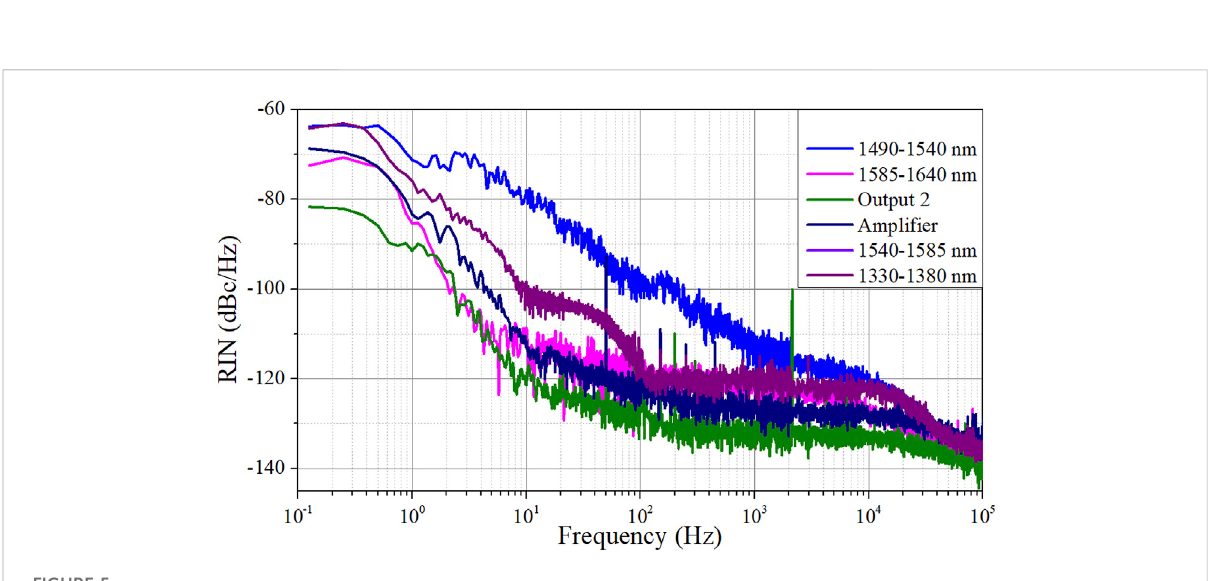
FIGURE 5 Relative intensity noises of the application